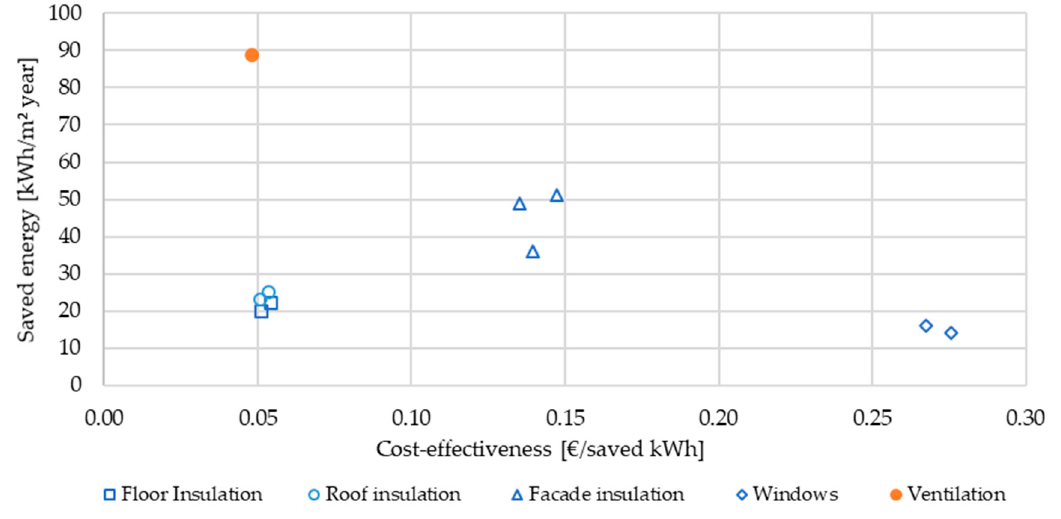
Figure 7. Cost-e ff ectiveness of single renovation actions investigated for the Swiss case study Figure 7. Cost-effectiveness of single renovation actions investigated for the Swiss case study building.